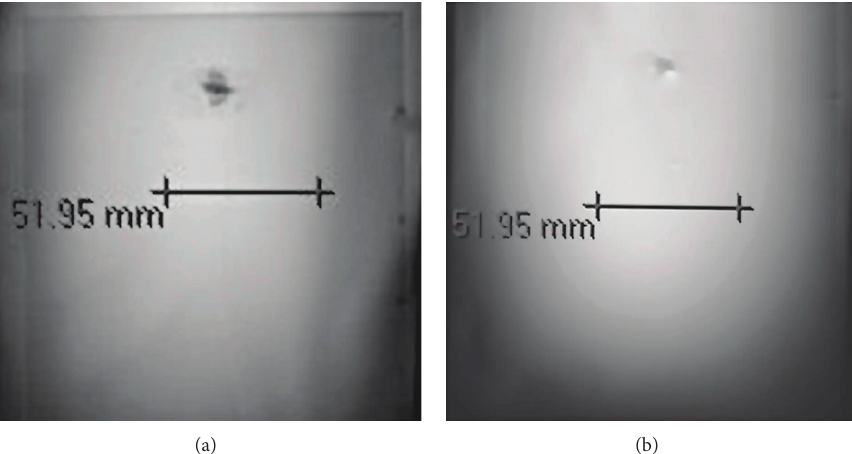
Figure 2: (a) MRI artifact associated with the tissue marker on a gradient echo pulse sequence (TR/TE, 100-msec/15-msec; flip angle, 30 degrees; long axis view; artifact area, 82-mm 2 ). The artifact appeared as a low signal intensity signal void that was relatively small in relation to the size and shape of the marker. (b) MRI artifact associated with the tissue marker on a spin echo pulse sequence (TR/TE, 500-msec/20- msec; long axis view; artifact area, 38-mm 2 ). The artifact appeared as a low signal intensity signal void that was relatively small in relation to the size and shape of the marker. Note that the artifact size was larger for the gradient echo pulse sequence (a) compared to that observed for the spin echo pulse